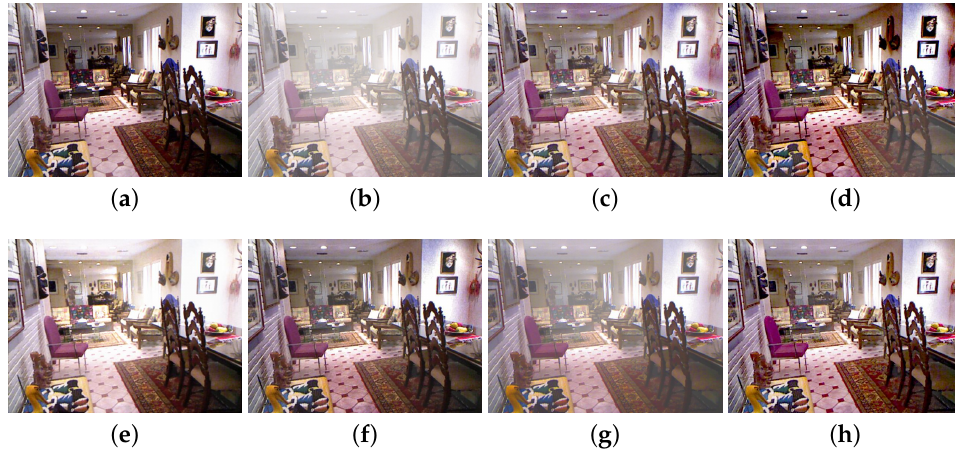
Figure 7. Drawing room of the SOTS-indoor dataset. ( a ) Ground truth image. ( b ) input blur image.